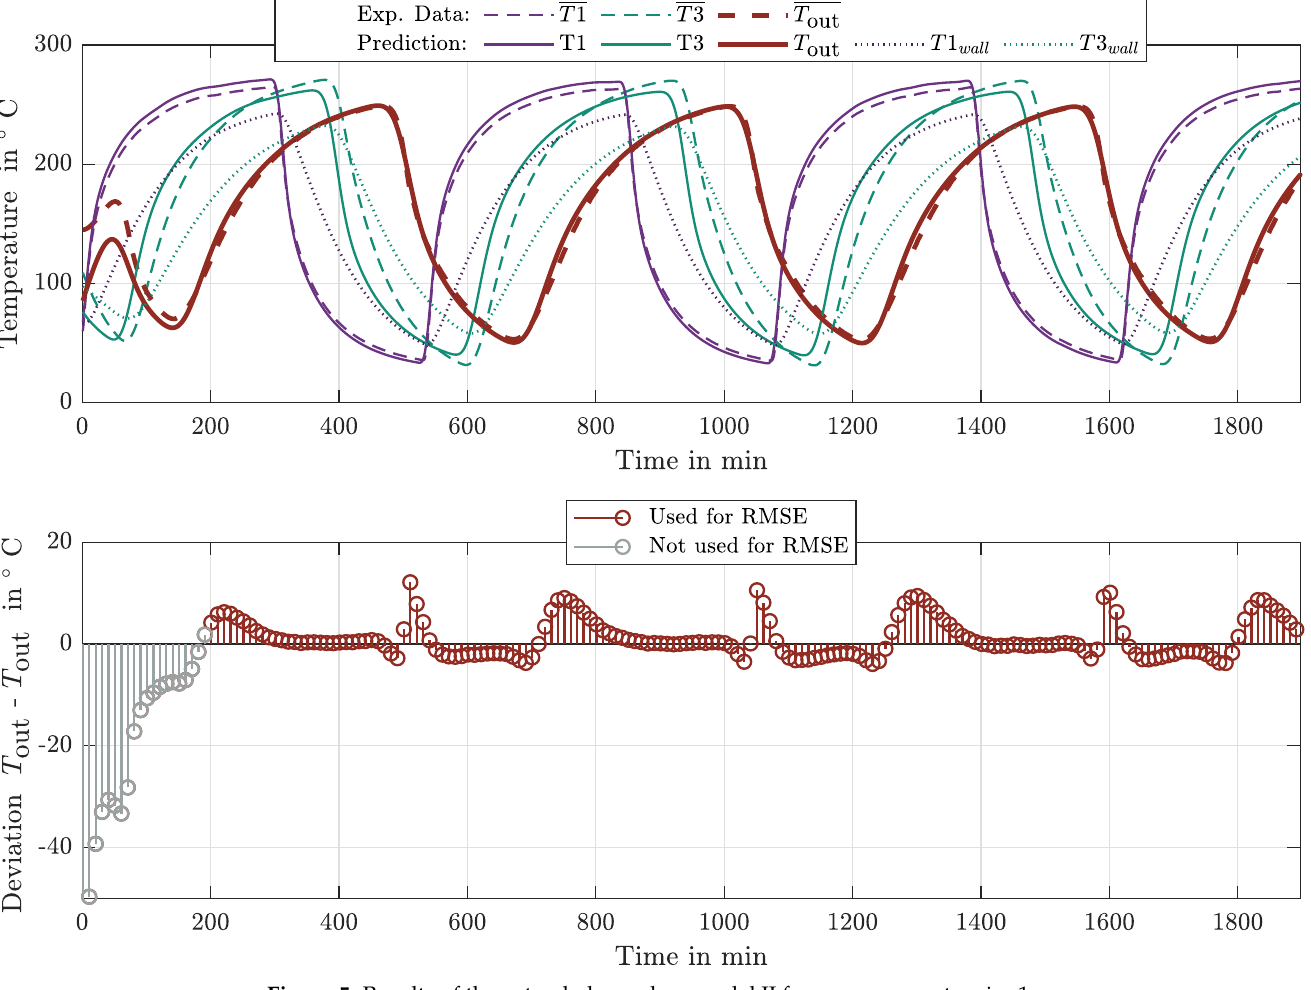
Figure 5. Results of the extended grey-box model II for measurement series